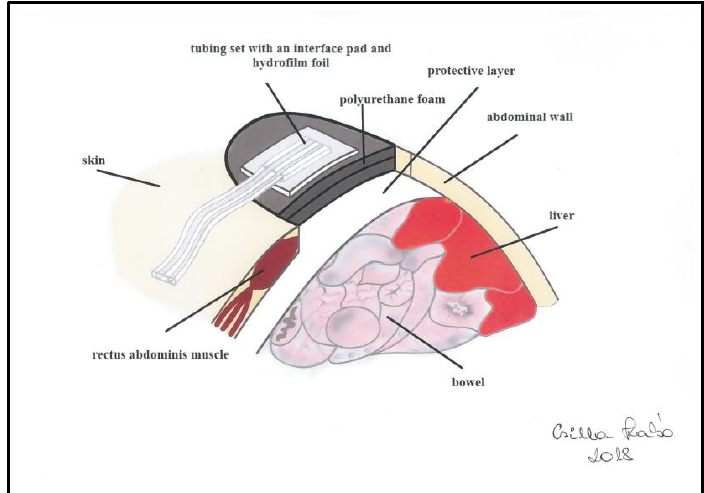
Figure 1. The negative pressure wound therapy system in the open abdomen management. In the hermetically closed system the continuous suction is transmitted to the abdominal cavity by the application of a special polyurethane foam. The bowels are covered by a protective layer to avoid direct contact between the abdominal organs and the foam. The negative pressure is provided by an electric device.